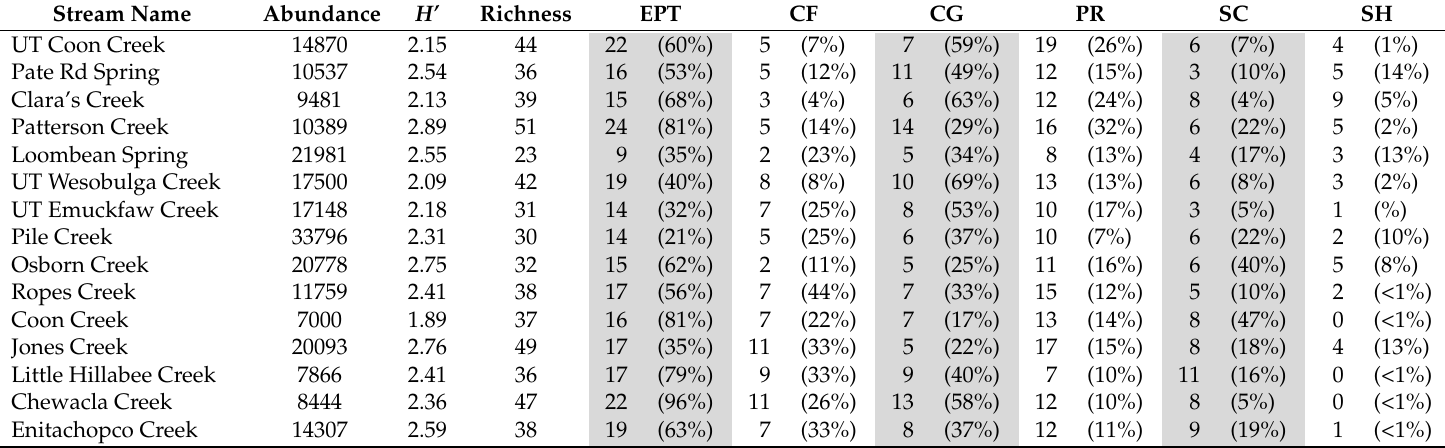
Table 9. Aquatic insect estimated abundance (#/m 2 ), diversity (Shannon’s H’ ), taxa richness, Ephemeroptera, Plecoptera, and Trichoptera taxa richness (EPT), collector/filterer richness (CF), collector/gatherer richness (CG), predator richness (PR), scraper richness (SC), and shredder richness (SH) across study streams. Values in parentheses are relative